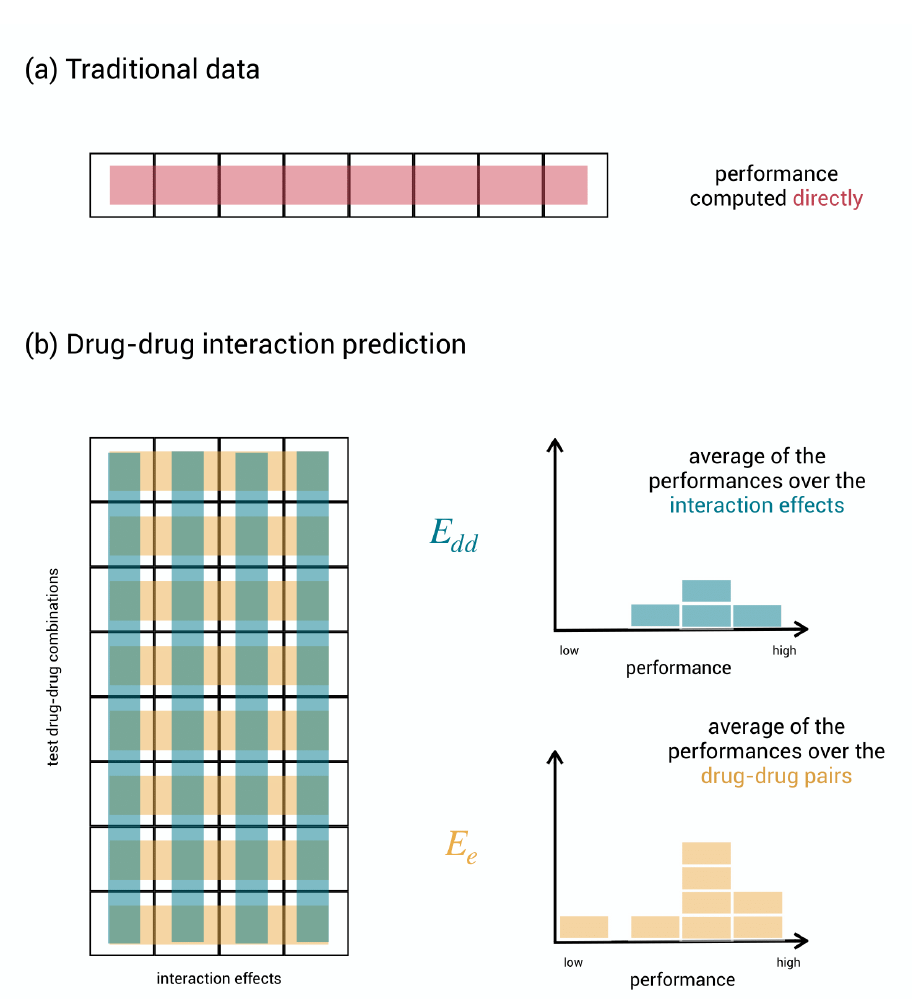
Figure 3. Evaluation schemes. ( a ) Regular, unstructured data where performance is computed directly by comparing the true test labels to the predicted test labels. ( b ) Aggregation of computations of performance in the matrix of test drug–drug pairs versus effects. In evaluation scheme E dd , for each effect, the performance measures how well the model can discriminate between drug–drug pairs. The E dd performances for the different effects can be gathered in a histogram and averaged to obtain a single final performance. In evaluation scheme E e , for each drug–drug pair, the performance measures how well the model can discriminate between effects. The E e performances for the different drug–drug pairs can be gathered in a histogram and averaged to obtain a single final